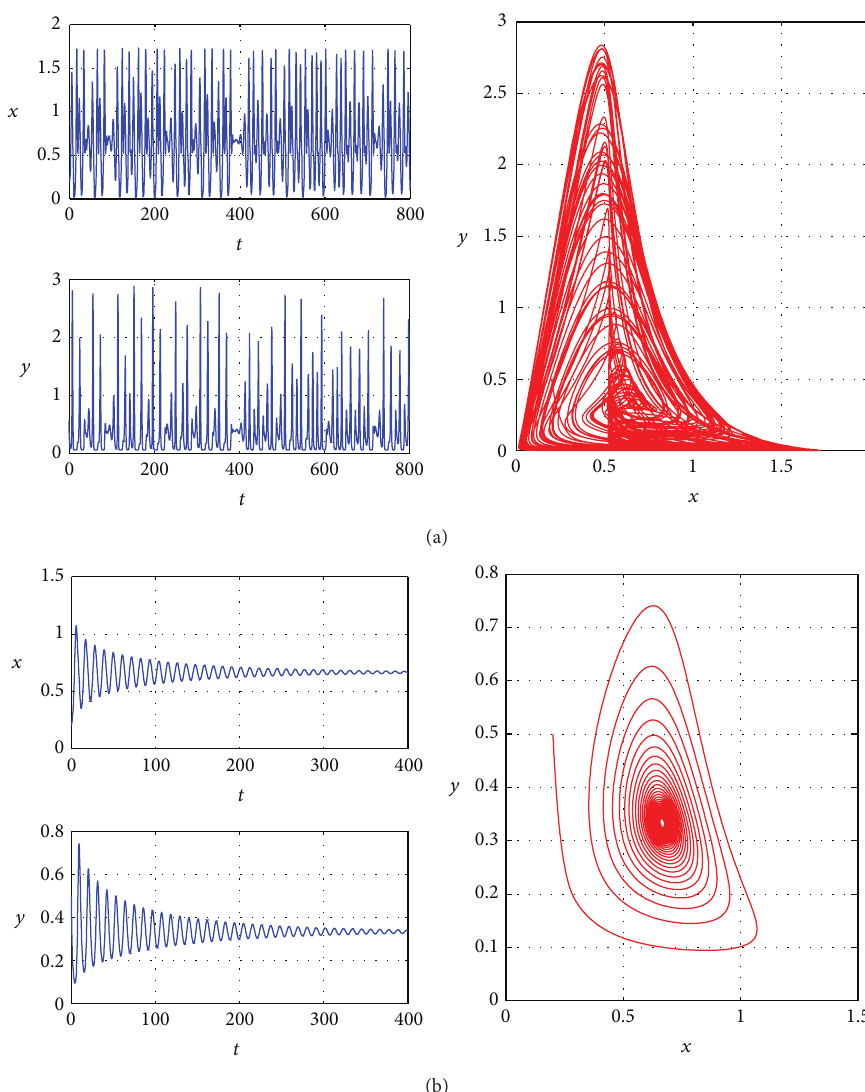
Figure 4: Waveform plot and phase plot of system (3) with 𝜏 = 1.4 : (a) 𝑘 1 = 𝑘 2 = 0 ; (b) 𝑘 1 = −0.2 , 𝑘 2 = −0.5